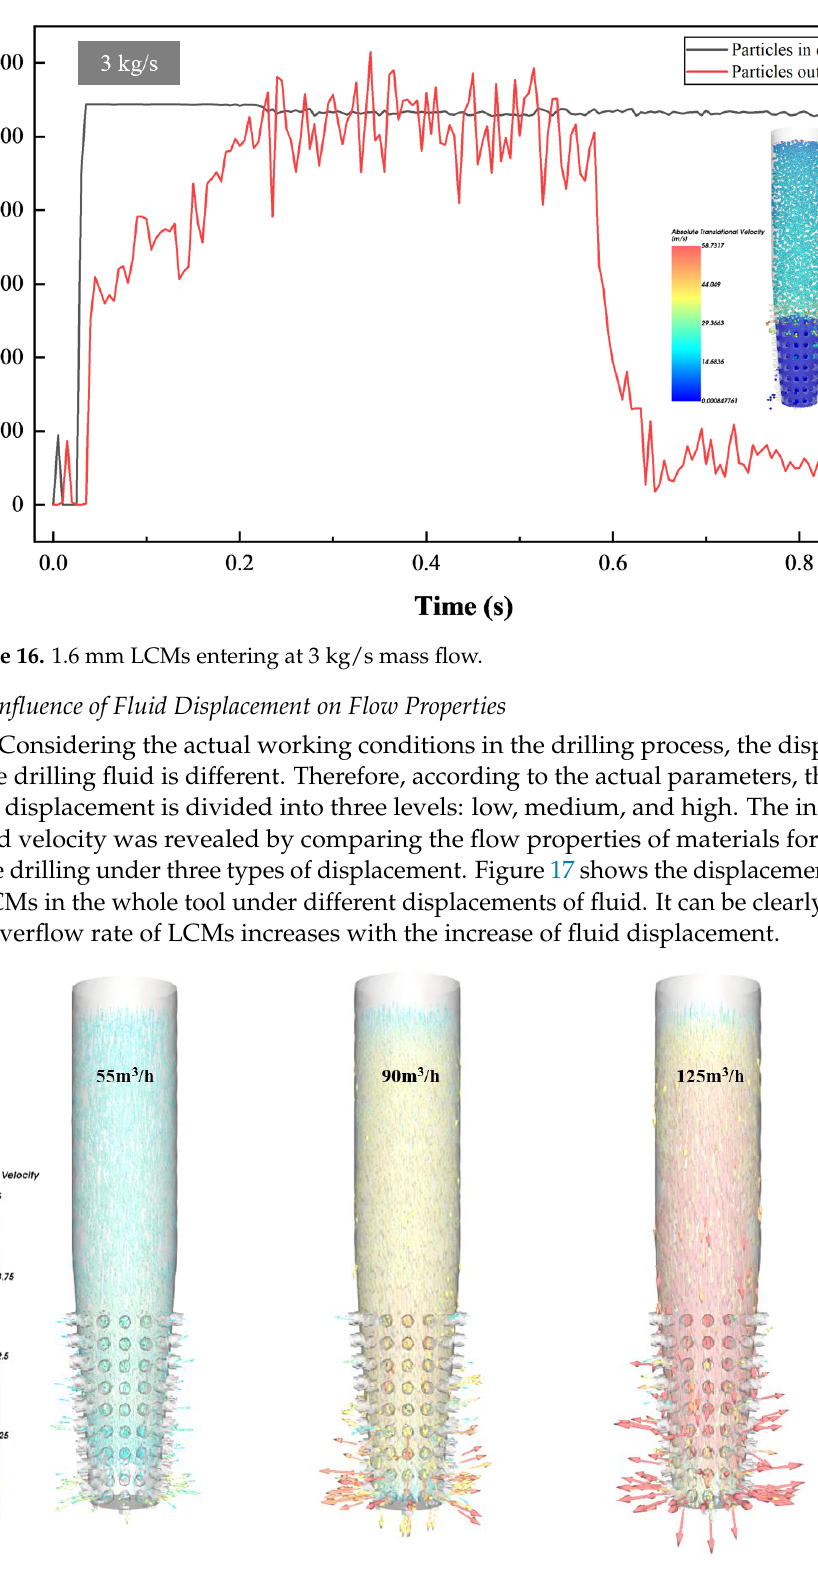
Figure 15. 1.6 mm LCMs entering at 2 kg/s mass flow.